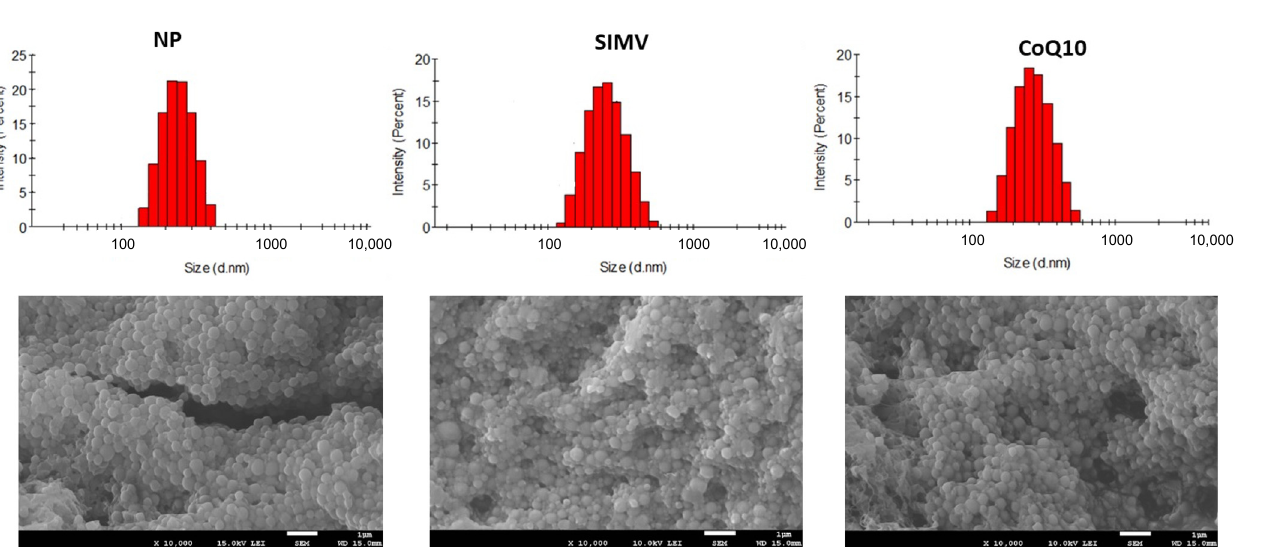
Figure 1. Graphic presentation of particle size according to the intensity obtained from dynamic light scattering (DLS) and pictures from scanning electron microscopy (SEM) for empty nanoparticles (NP) and NP loaded with simvastatin (SIMV) or coenzyme Q10 (CoQ10). Table 1. Characteristics of pure and loaded nanoparticles (NP) determined with dynamic light scat- tering (DLS) of the NP.